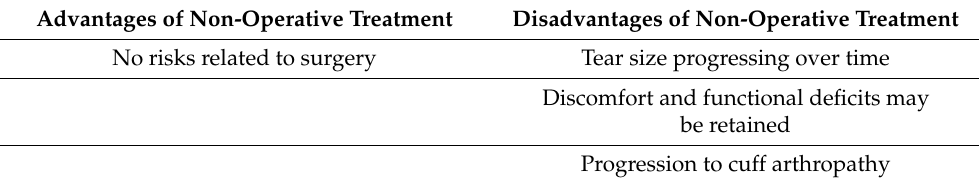
Table 1. Advantages and disadvantages of non-operative treatment in the management of irreparable rotator cuff tears.